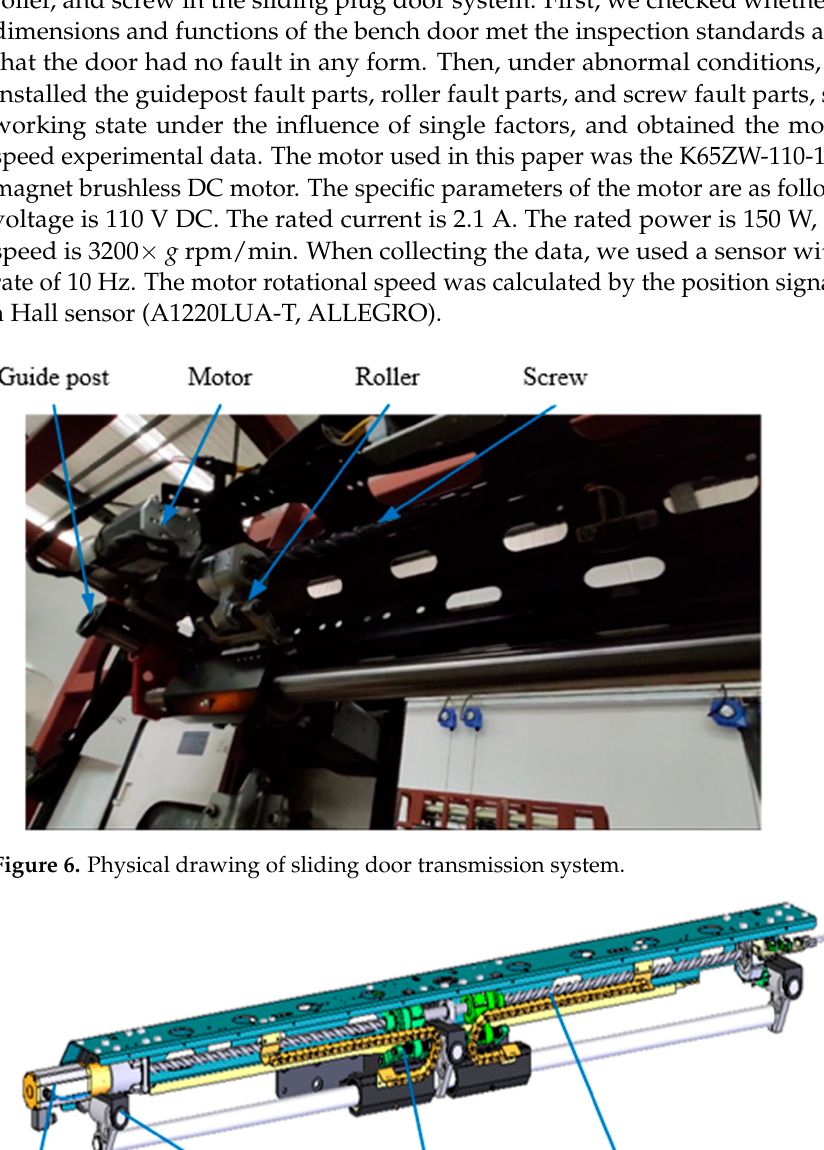
Table 3. Specific interval range and data information of four types of benches.